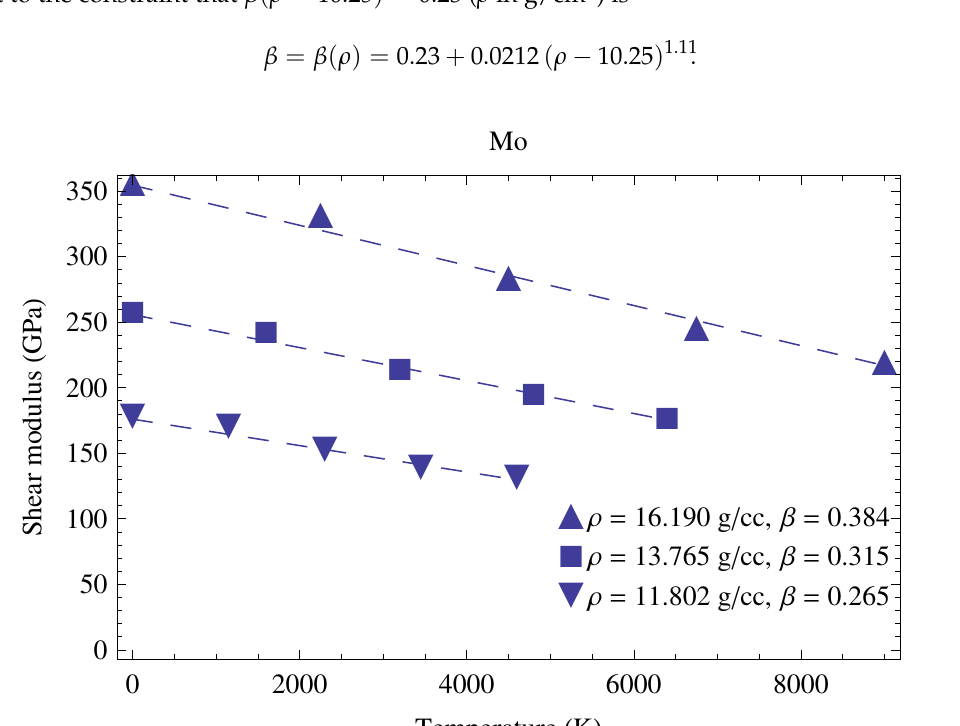
Figure 10. The shear modulus of bcc-Mo as a function of T at three different densities. The dashed lines represent the three corresponding forms of Equation